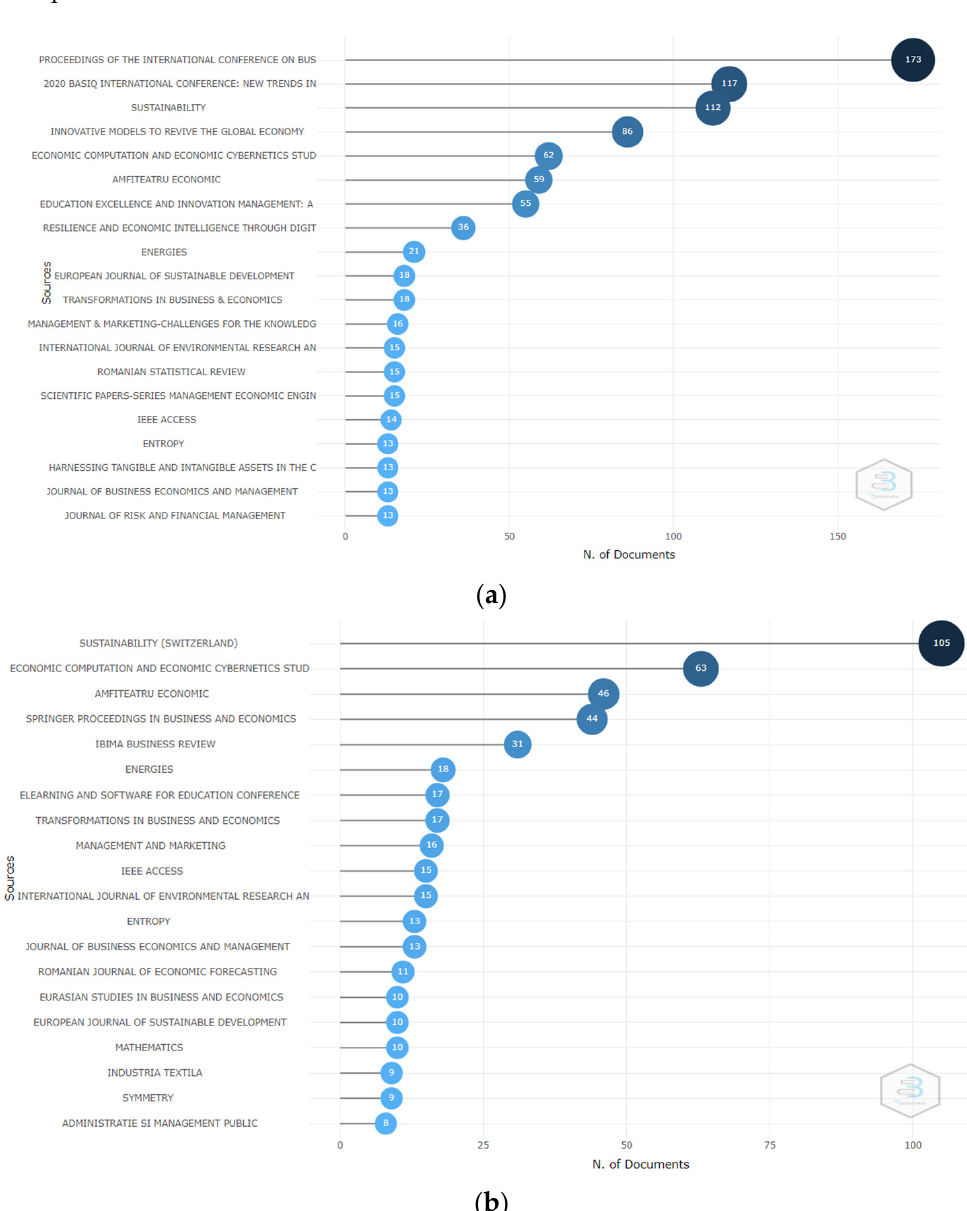
Figure 3. Twenty most productive sources. ( a ) WoS. ( b ) Scopus. According to Bradford’s Law, the first four most productive sources are the core sources out of the 254 records and represent the nucleus of journals published by the authors affiliated with the Bucharest University of Economic Studies. In Figure 4a, the core zone represents 37.4% of the total sources of the WoS database. It includes the following sources: